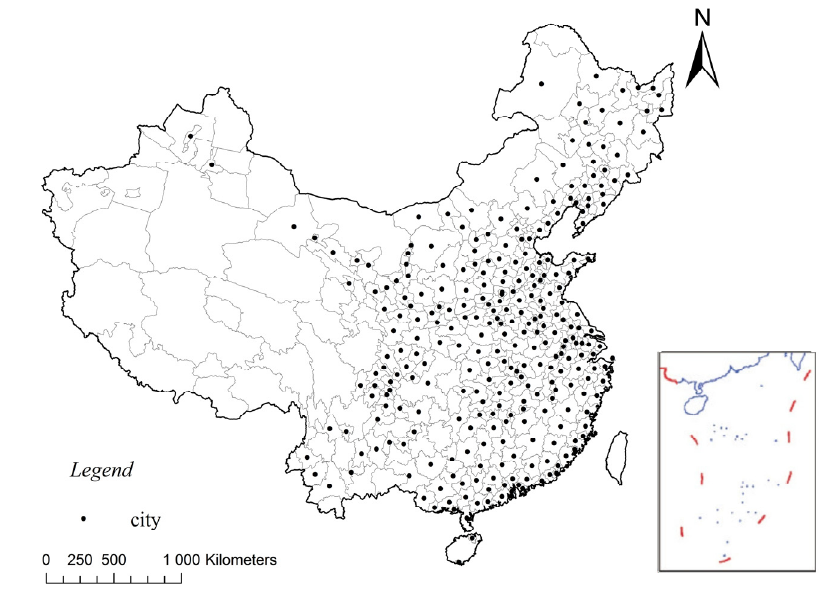
Figure 1. Location of the study area.